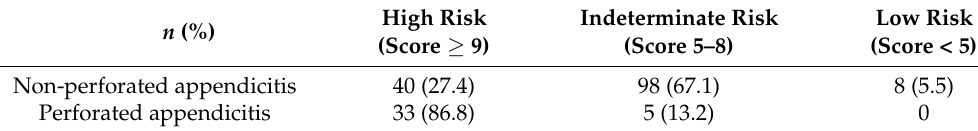
Table 5. Patient risk stratification based on the AIR